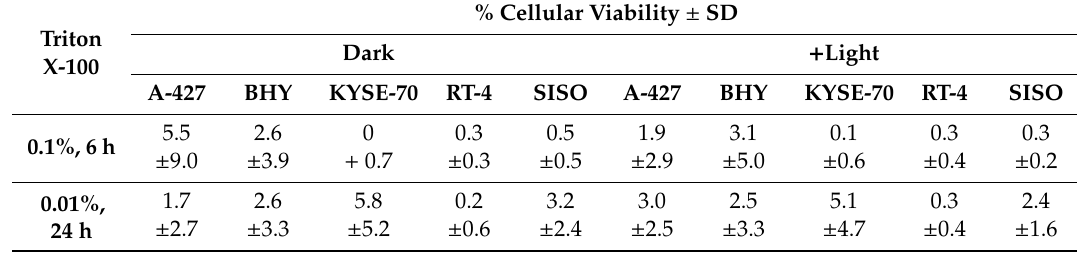
Table A1. Established % cellular viability as assessed by the MTT cell viability assay (with remaining cells from LDH release assay) after treatment of cells with 0.1% ( v / v , 6 h) and 0.01% ( v / v , 24 h) Triton X-100 positive control after incubation in the dark and post illumination with 1.8 J / cm 2 (24 h) or 3.5 J / cm 2 (6 h), respectively. Results as means ± SD from at least three independent